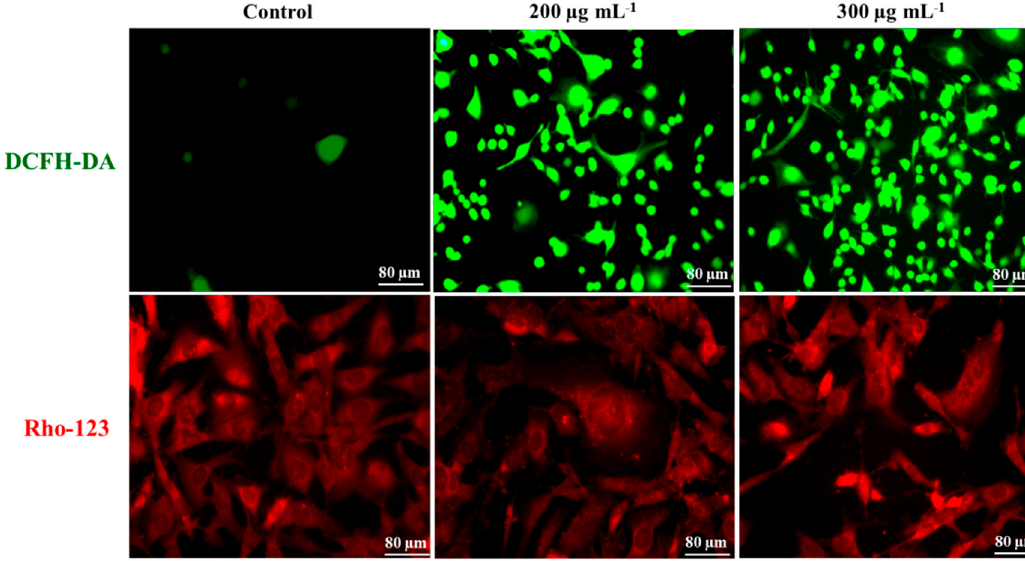
Figure 6. DCFH-DA staining of MBA-MD-231 cells following 1 h of PDT treatment with or without phycocyanin. Rho-123 staining demonstrated loss of mitochondrial membrane potential after 24 h of PDT treatment. The PDT treatment was performed using 625-nm laser for 30 min at 80 mW·cm − 2 power density.